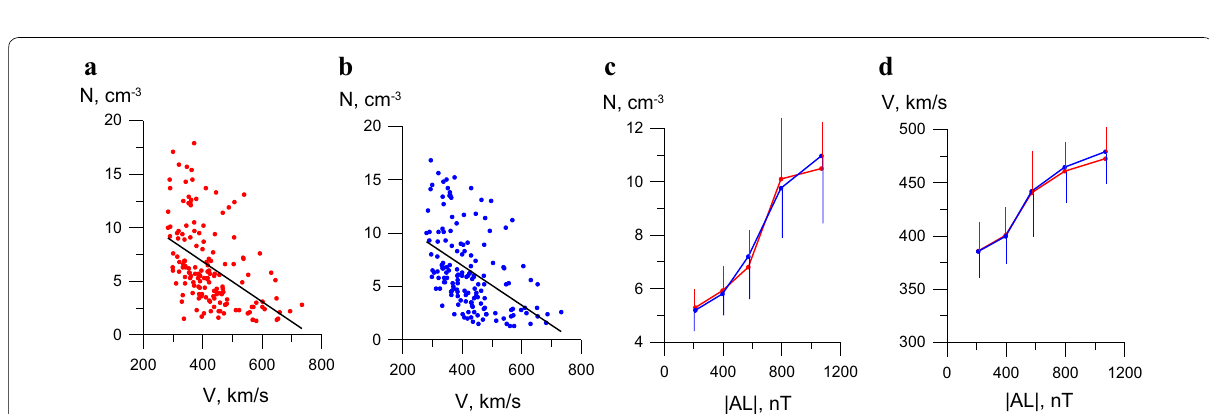
Fig. 2 Relationship between the solar wind plasma density and velocity for the time intervals of 1 h before ( a red dots) and after ( b blue dots) substorm onset. The average values of the solar wind density ( c ) and velocity ( d ) for substorms of different intensities. The averaging is made 1 h before (red) and 1 h after (blue) onsets. Data are averaged in the 200-nT bins starting from 100